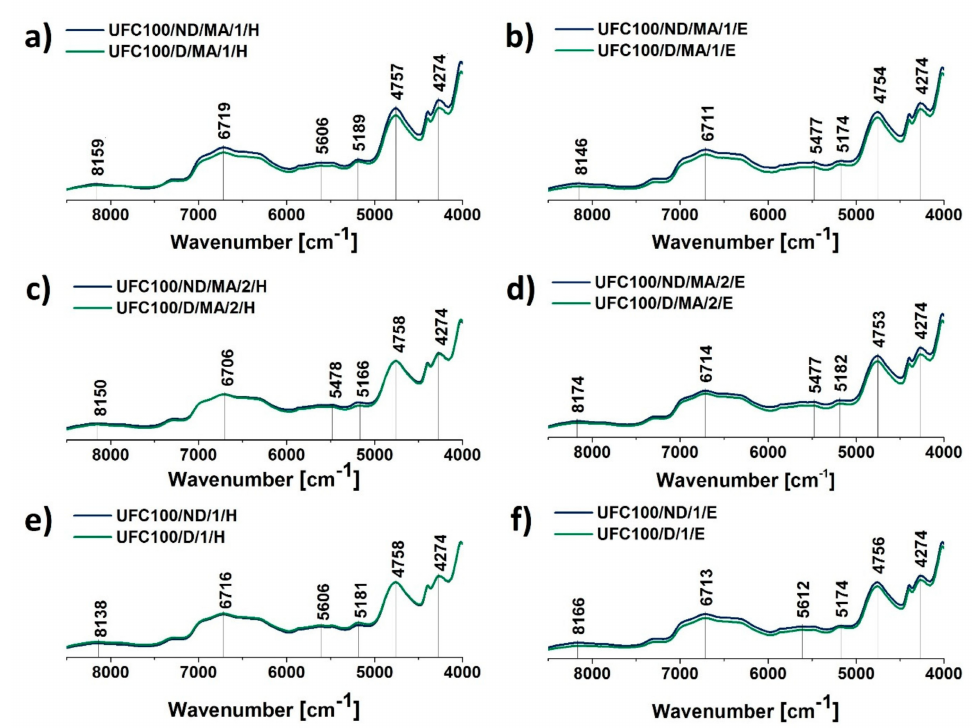
Figure 7. NIR spectra of cellulose samples modified via a hybrid chemical approach and solvent treatment: ( a ) solvent exchanged to hexane and then MA treated, ( b ) solvent exchanged to ethanol and then MA treated, ( c ) MA treated and then solvent exchanged to hexane, ( d ) MA treated and then solvent exchanged to ethanol, ( e ) solvent exchanged to hexane, ( f ) solvent exchanged to ethanol. Characteristic absorption bands: 8165 cm − 1 (C–H), 7290 cm − 1 (C–H), 6772 cm − 1 (O–H), 6706 cm − 1 (O–H, water), and 4754 cm − 1